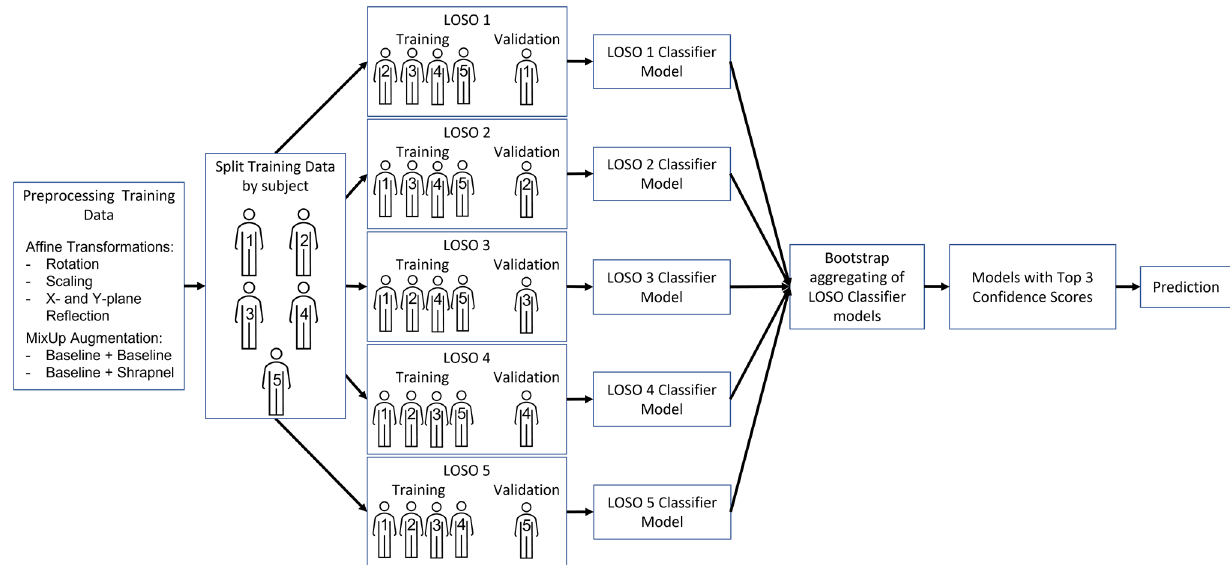
Figure 2. Flowchart describing the methods of this study, from data augmentation to final top 3 predictions, using LOSO training methodology to develop the final ensemble model.